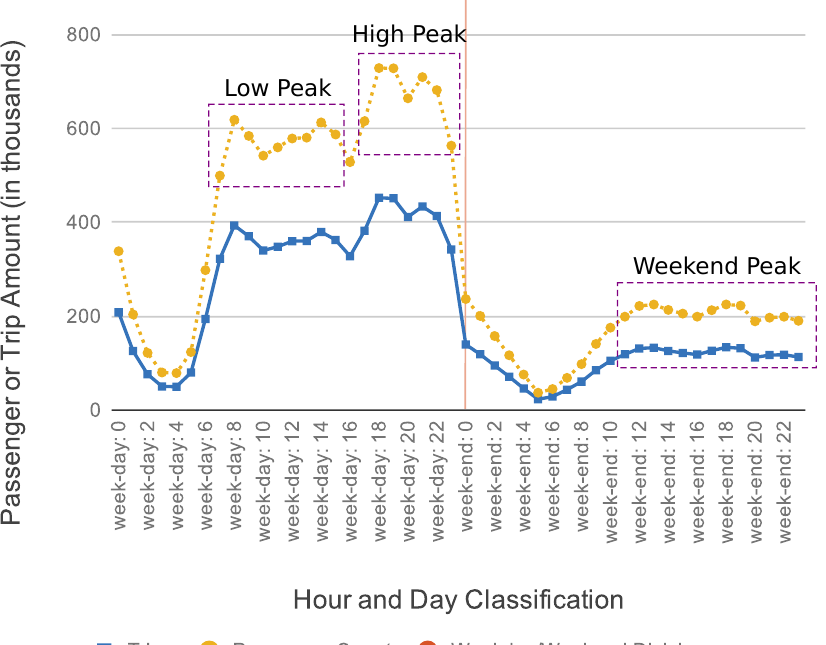
Figure 4. Distribution of trips and passengers in weekdays and weekends per hour; 48 classes were created for every hour of the day in weekdays and weekends